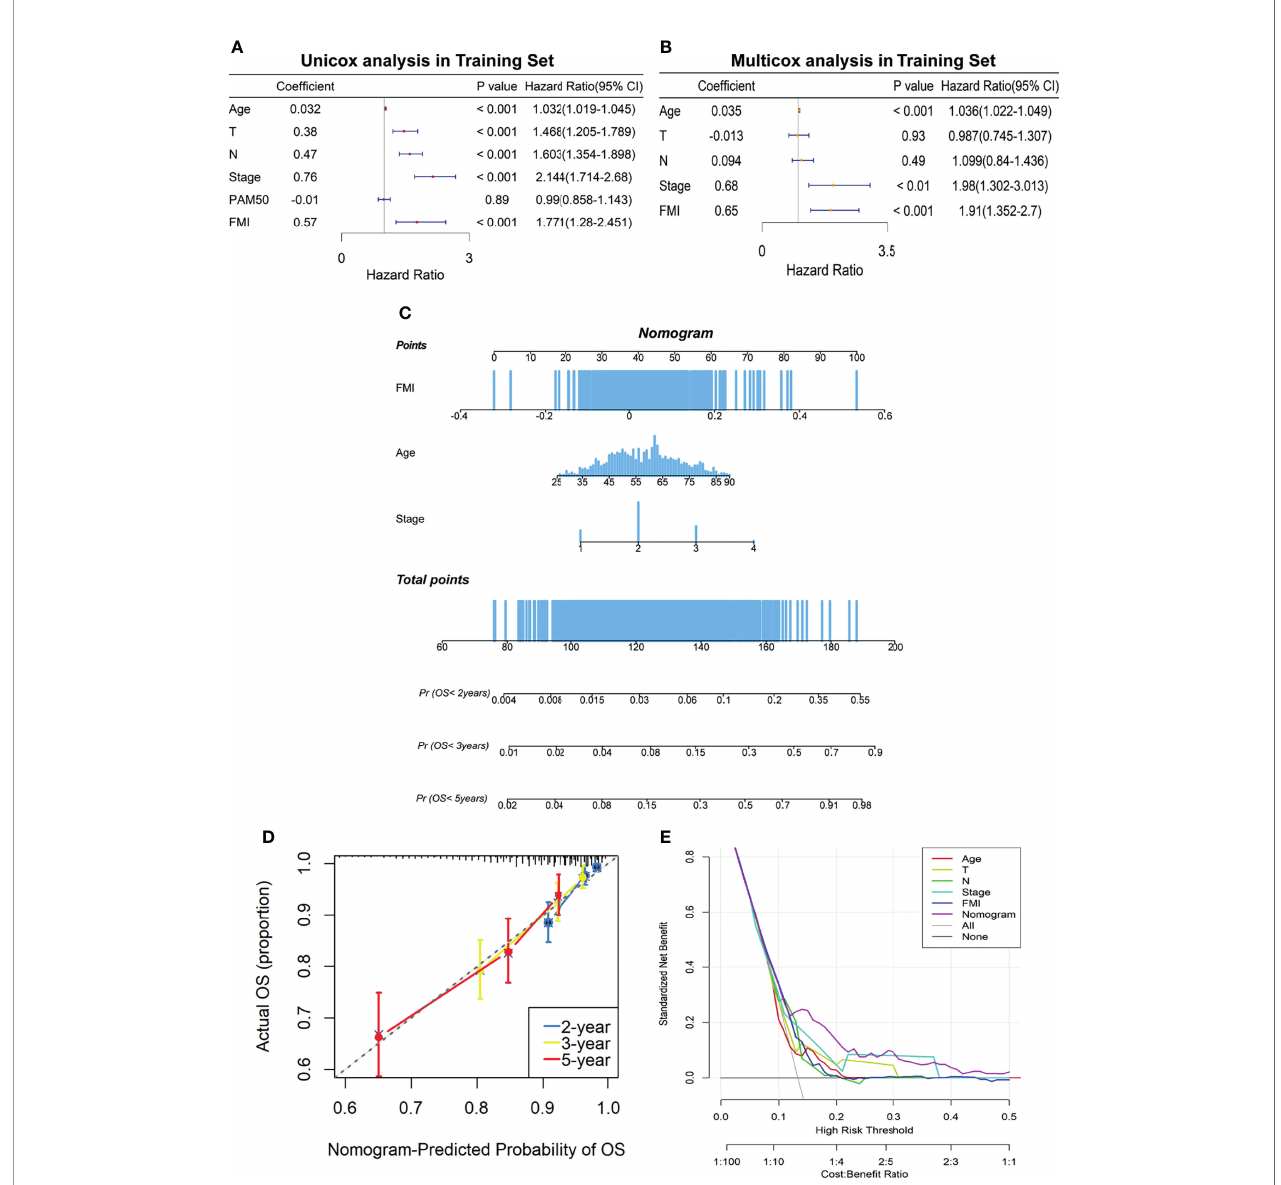
FIGURE 5 | Establishment of FA metabolism-related clinicopathologic nomogram. (A) Univariate Cox regression analysis of the signature FMI and clinical parameters. (B) Multivariate Cox regression analysis of the signature FMI and clinical parameters. (C) Development of a prognostic nomogram to predict 2-, 3-, and 5-year OS in BC patients of the training set. (D) Calibration curve to evaluate the consistency of predicted and actual OS. (E) Decision curve analysis (DCA) to assess the clinical decision-making bene fi ts of the nomogram. FA, fatty acid; FMI, fatty acid metabolism index; OS, overall survival; BC, breast